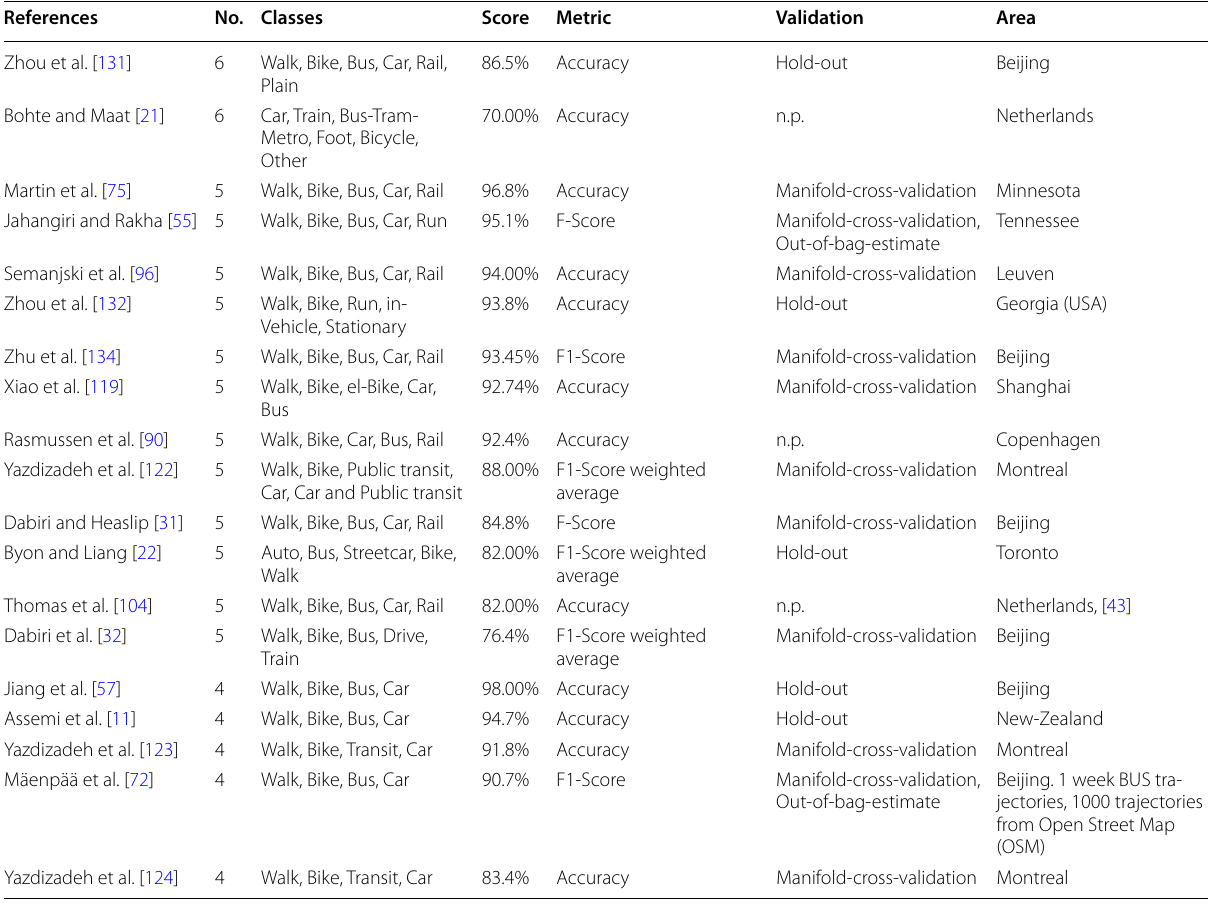
Table 1 Classification task ranked by difficulty and score, for mode